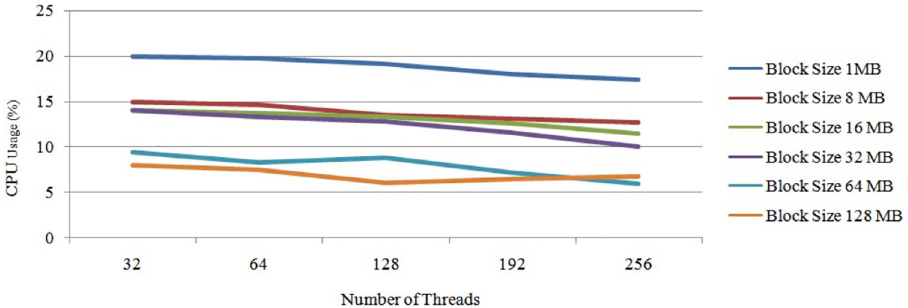
Fig 11. Performance of CPU threads at each DataNode on Hadoop cluster.